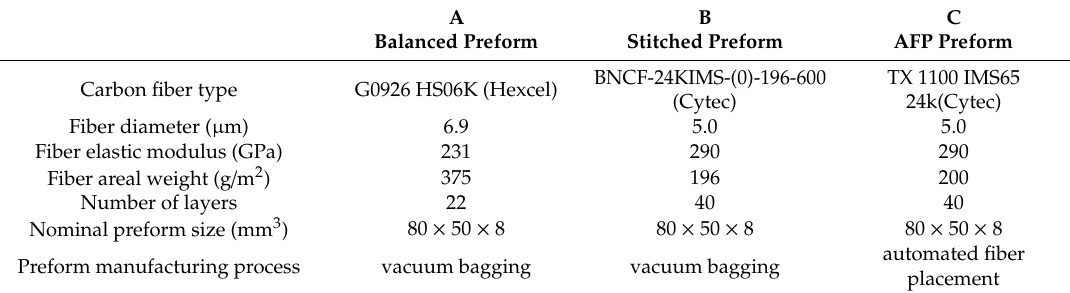
Figure 1. Preforms for permeability measurements: ( a , d ) balanced, ( b , e ) unidirectional (UD) stitched and ( c , f ) unidirectional (UD) consolidated by AFP. Table 1. Carbon fiber preform configuration.